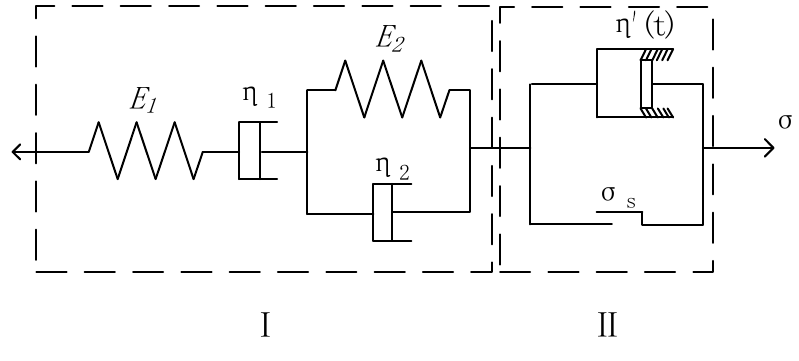
Figure 17. New creep model of coal and rock.